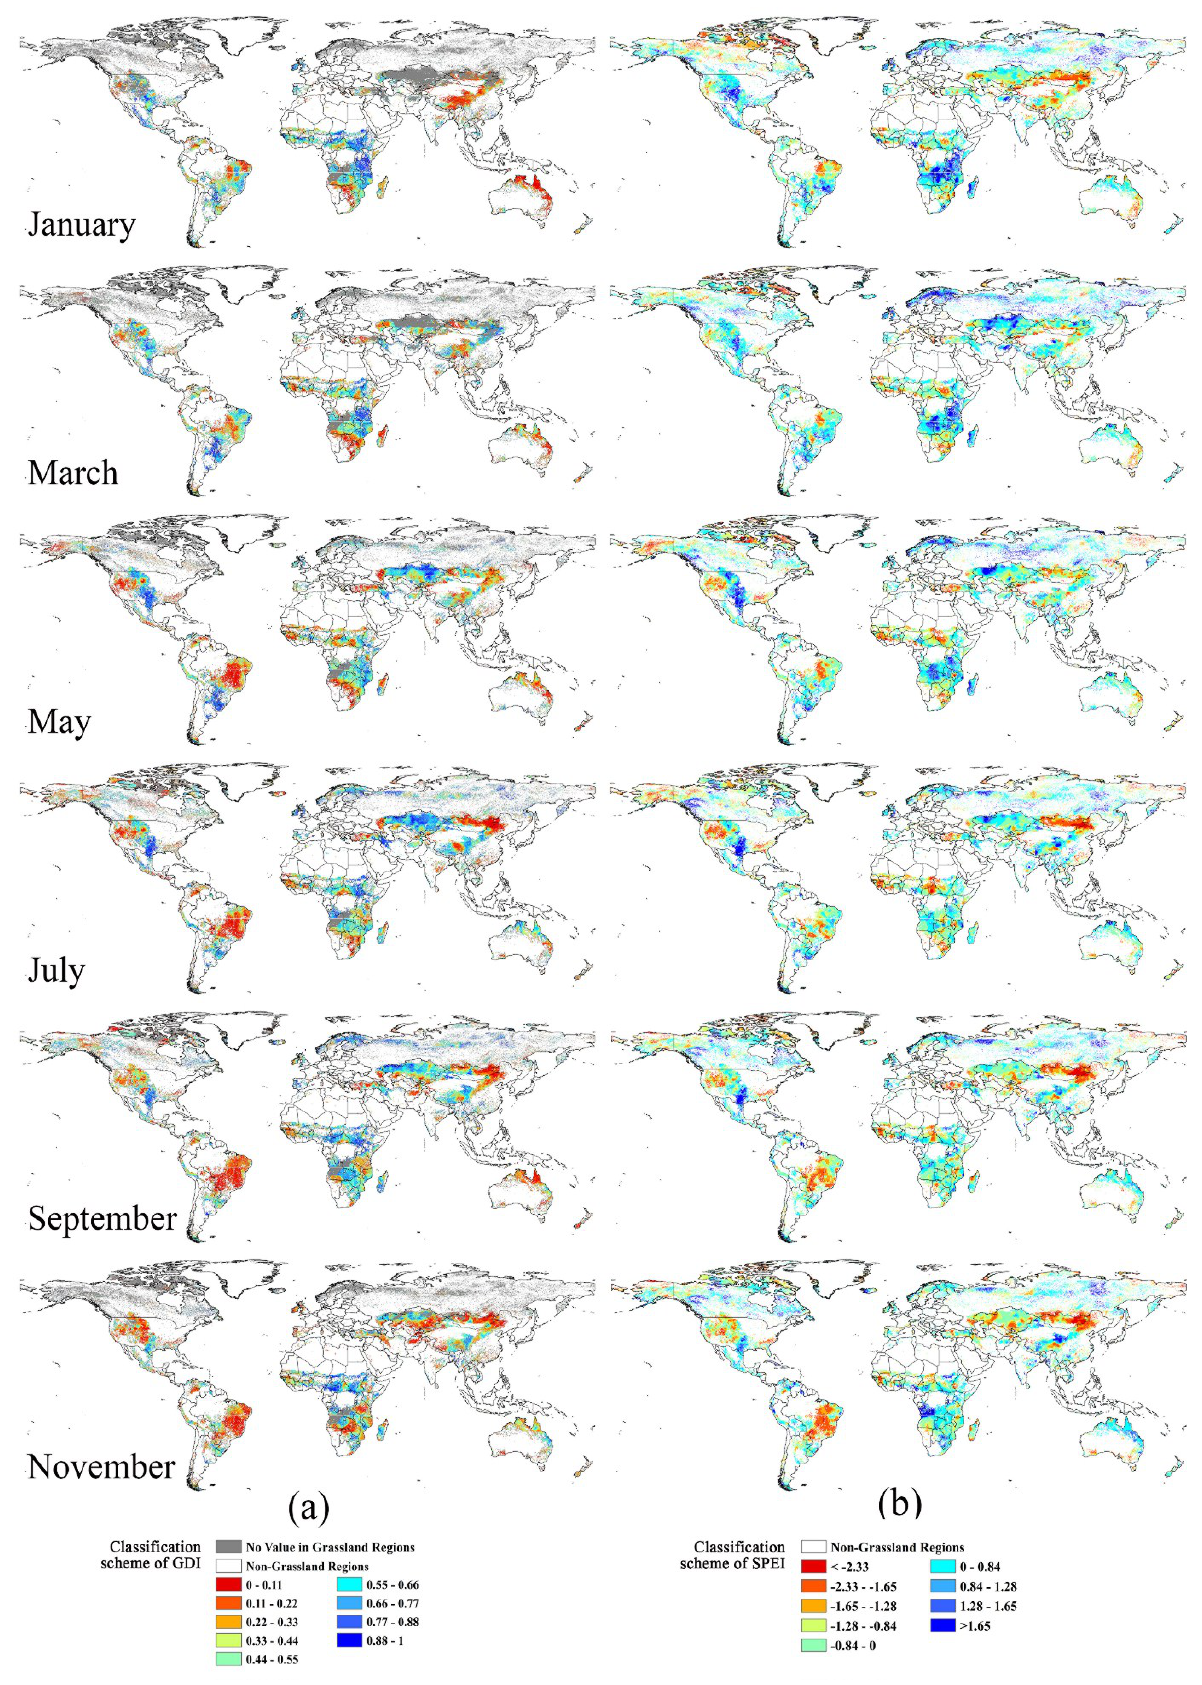
Figure 10. The global distribution of the GDI-6CRU and SPEI-6mon for grassland regions in different months of 2007. ( a ) GDI-6CRU; ( b )